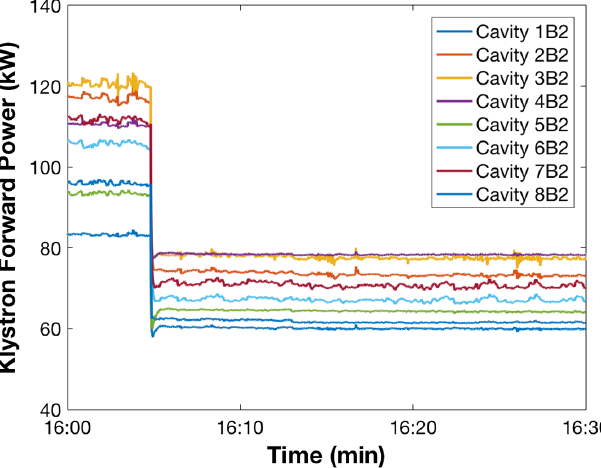
FIG. 19. Average klystron forward power. 2220 bunches, beam 2.